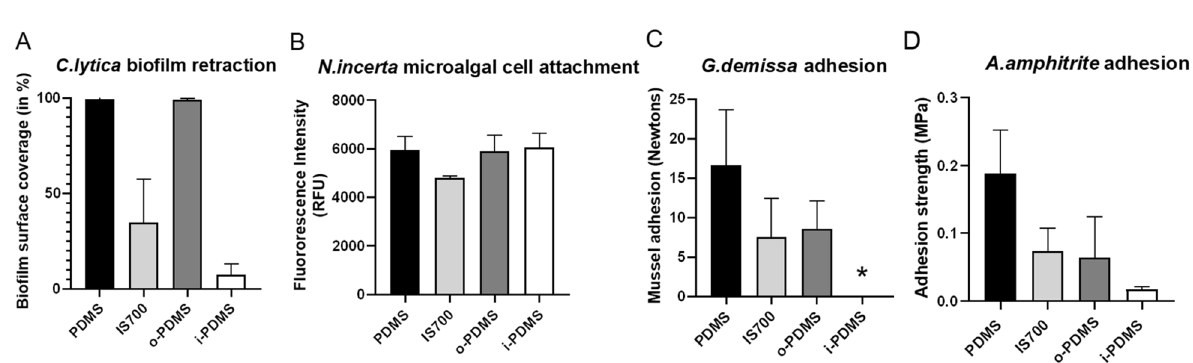
Figure 2. Comparative performance of o-PDMS, i-PDMS, Intersleek 700 and a PDMS control coating in marine fouling assays. Surfaces were tested for anti-adhesion performance against ( A ) bacteria ( Cellulophaga lytica ) (N = 3), ( B ) microalgal diatoms ( Navicula incerta ) (N = 4), ( C ) mussels ( Geukensia demissa ) (N = 6) and ( D ) barnacles ( Amphibalanus amphitrite ) (N = 6). Error bars = standard deviation (SD). * Signifies no adhesion took